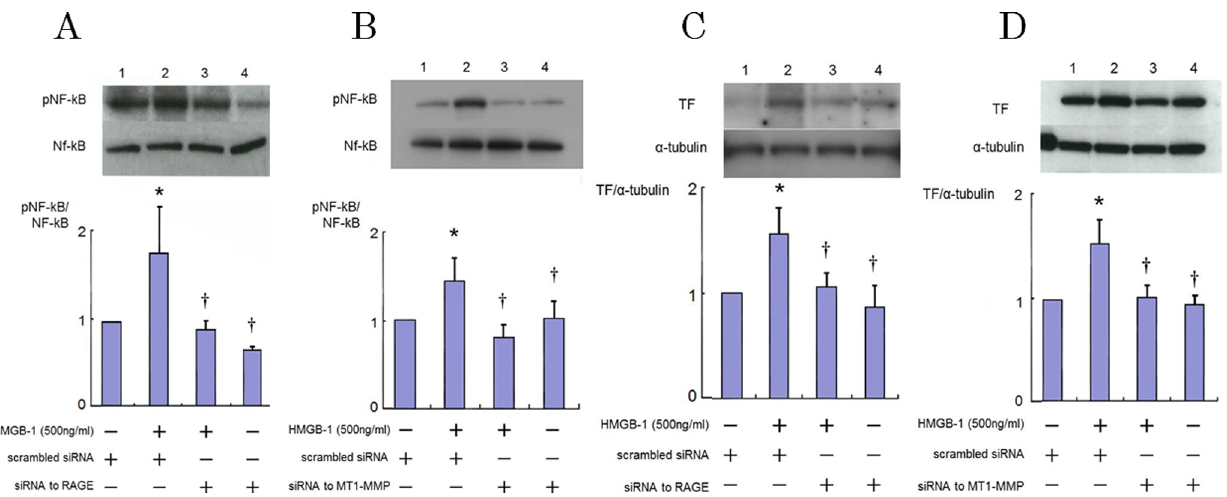
Fig. 7. Role of RAGE and MT1-MMP in NF- k B phosphorylation (A, B) and HMGB-1-triggered upregulation of TF (C, D) in endothelial cells. HAECs were transfected with siRNA to RAGE or MT1-MMP and then stimulated by HMGB-1 for 30min (A, B) or 18 hours (C, D), followed by Western blotting. Immunoblots are from an experiment representative of 3 similar experiments. Quantitative results of TF (obtained by densitometry) were normalized for a - tubulin levels. Bars are mean ¡ S.D. of quantitative densitometric analyses from 3 separate experiments. * P , 0.05 vs Lane 1; { P , 0.05 vs. Lane 2.